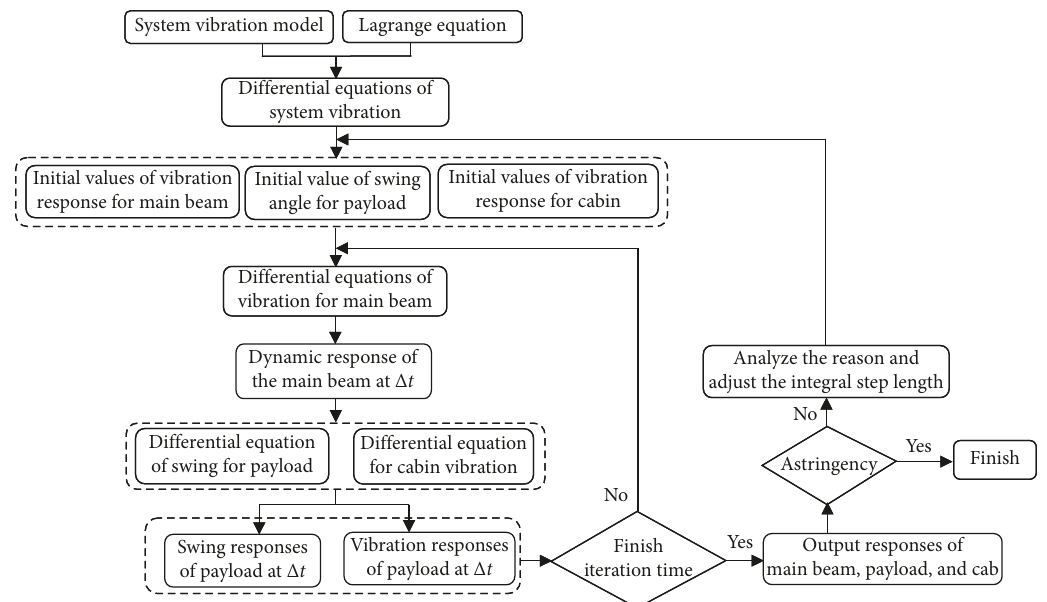
Figure 7: Calculation processes of nonlinear vibration